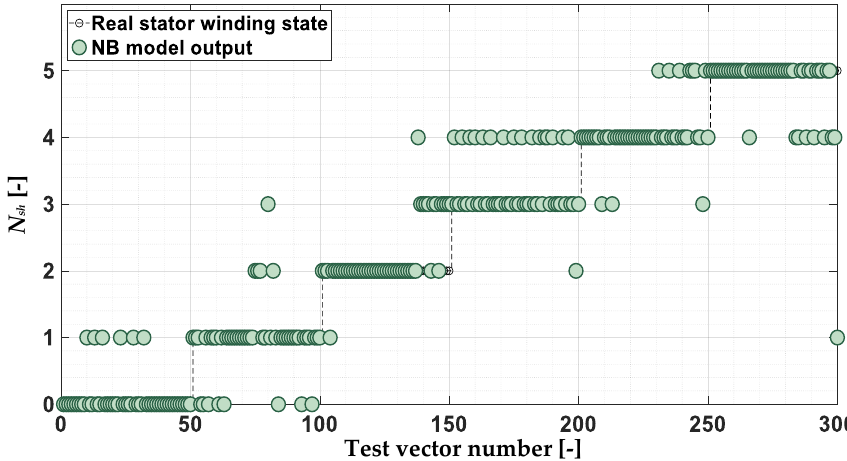
Figure 19. Response of the NB stator winding fault classifier to the test data set.